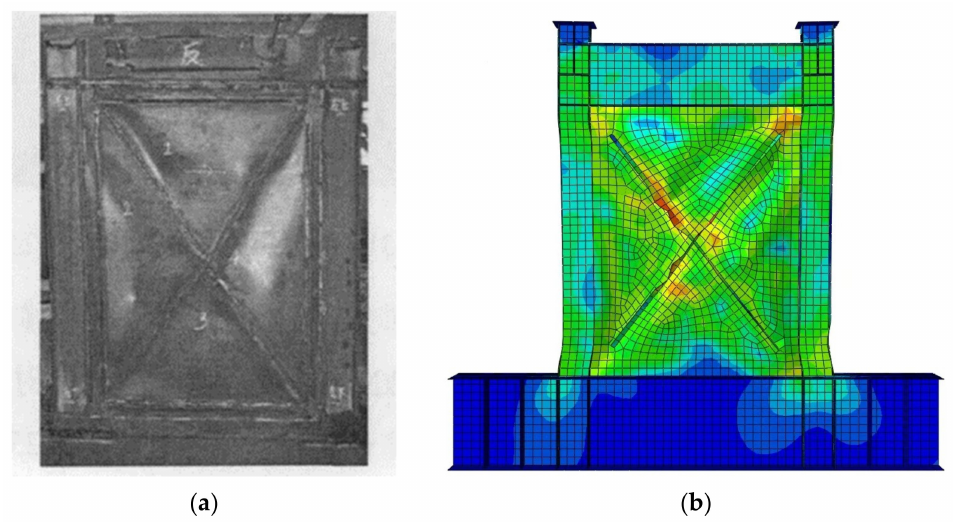
Figure 5. Comparison of failure modes of SPSWs. ( a ) Failure mode of test. ( b ) Failure mode of model.